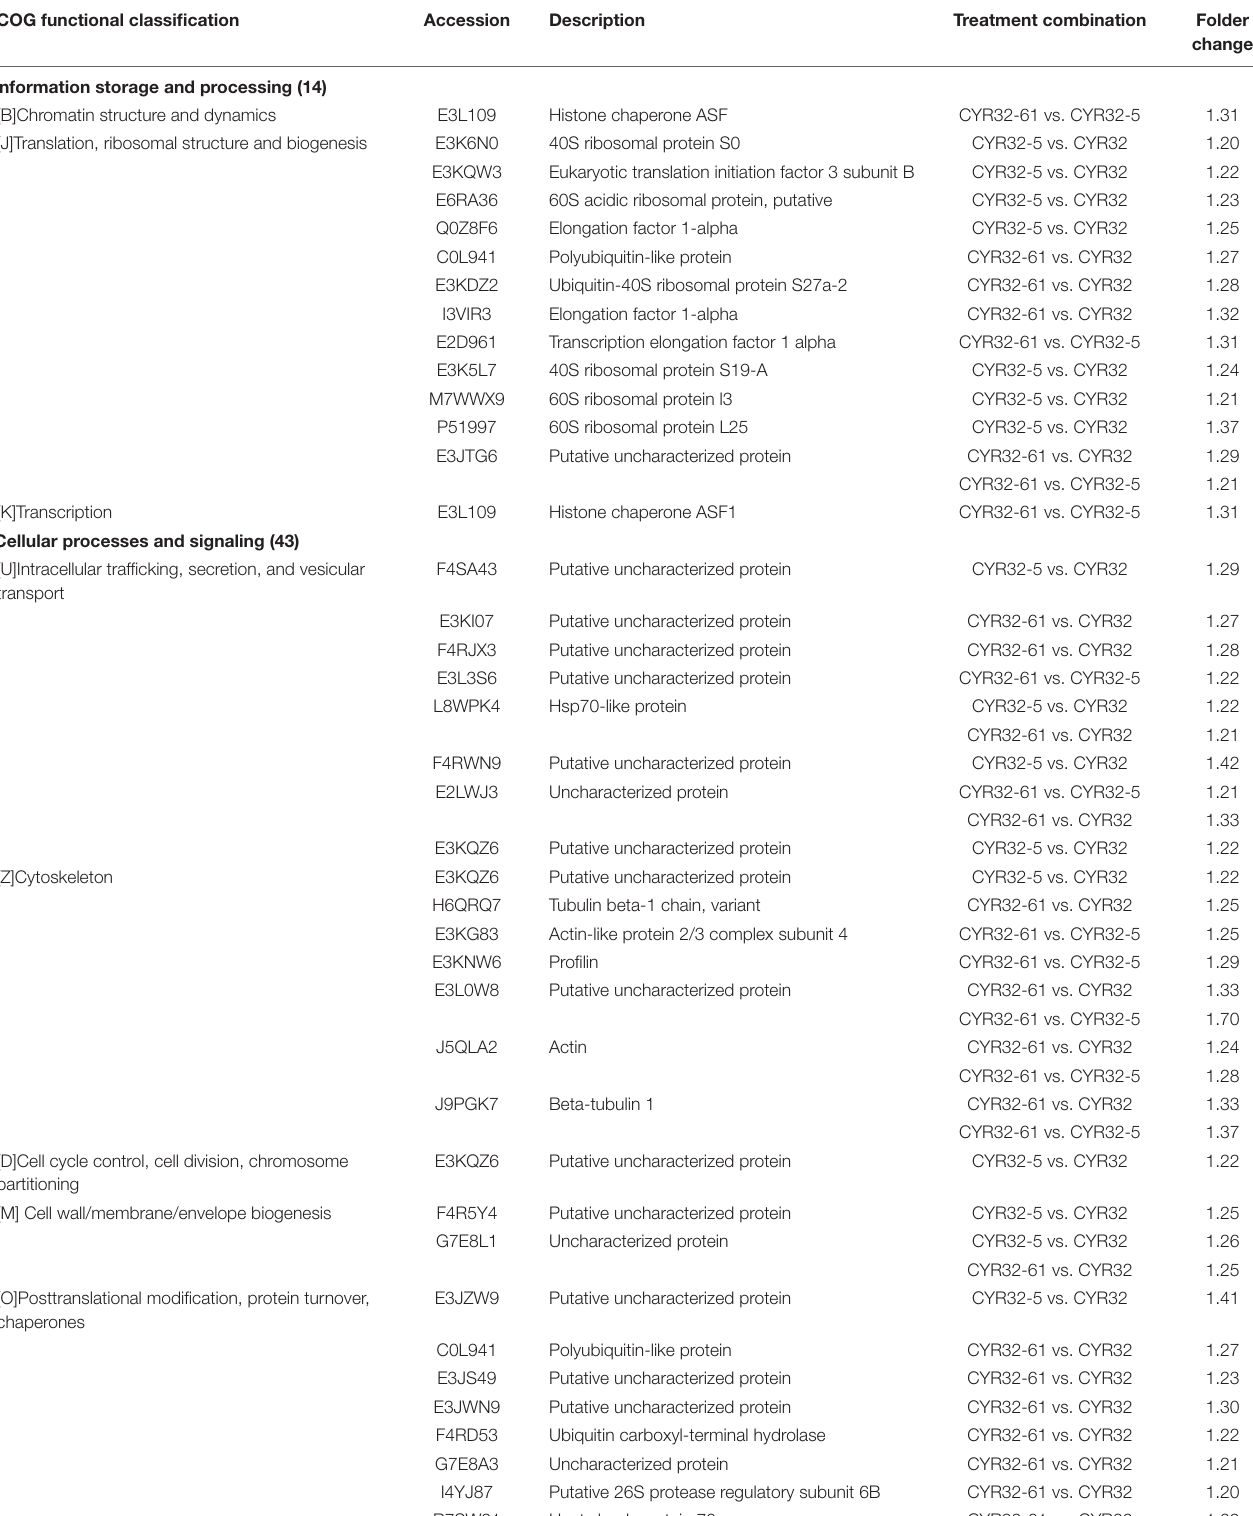
TABLE 2 | Functional annotations of the up-regulated differentially expressed proteins acquired in the combinations CYR32-5 vs. CYR32, CYR32-61 vs. CYR32, and CYR32-61 vs.